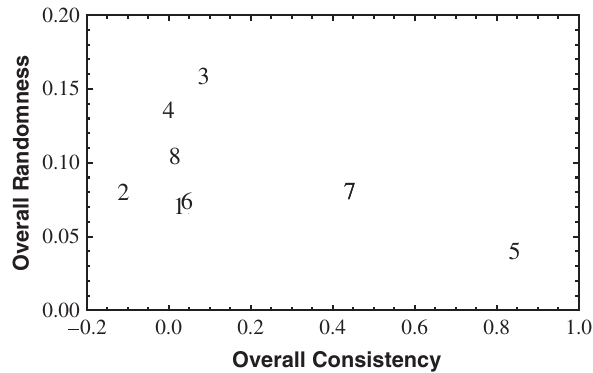
FIG. 12. Overall randomness versus overall consistency for eight statements of the form ‘‘[the higher trajectory] will have a longer time of flight than [the lower trajectory]’’ that correspond to the eight projectile pairs shown in Fig. 11. This statement should be answered ‘‘true’’ in each